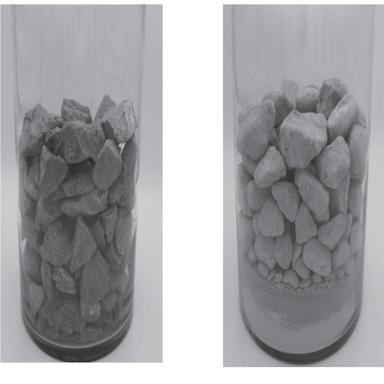
Ballast material before and afterthought LA abrasion machine: (a) fresh ballast, and (b) used ballast.